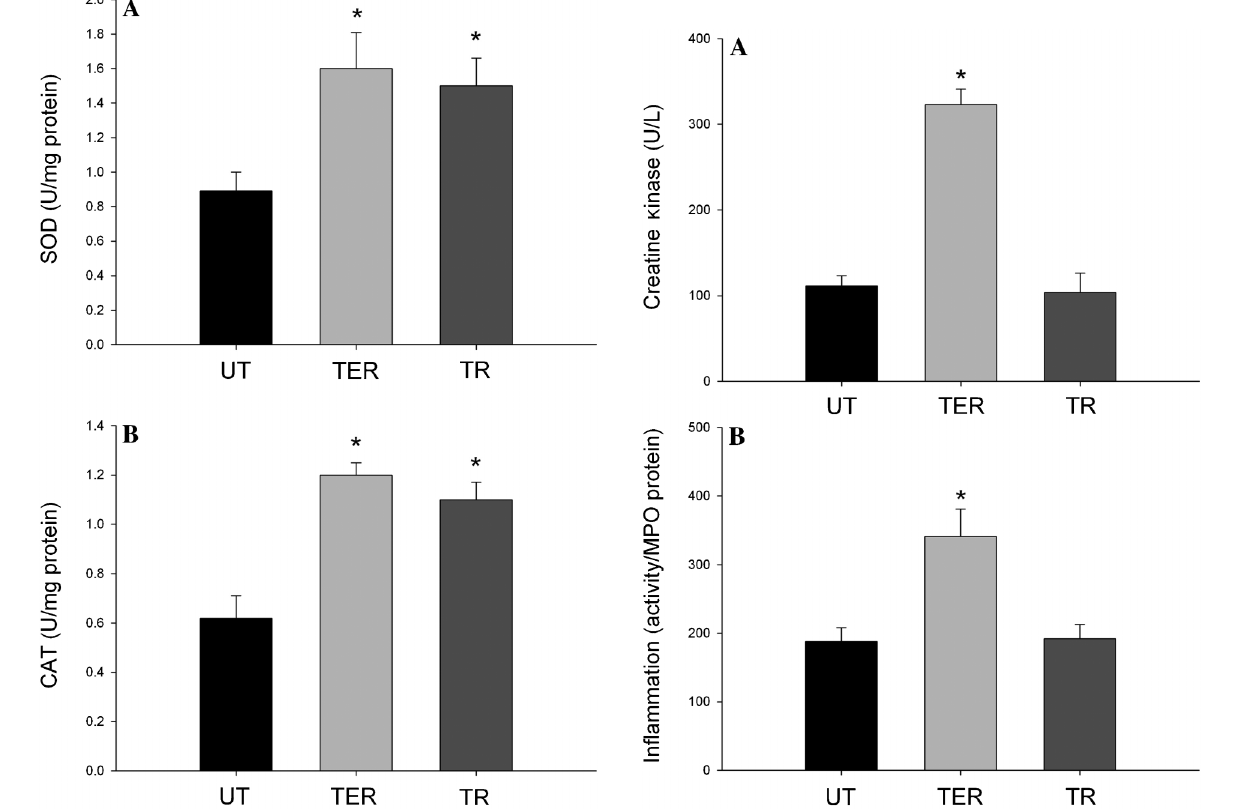
Figure 3. Antioxidant enzyme levels [ A , superoxide dismutase (SOD) and B , catalase (CAT)] were determined in skeletal muscle (red portion - quadriceps) 48 h after the last training session. The animals were divided into 3 groups (N = 6 each): UT = untrained; TER = trained eccentric running (16 ˚ ); TR = trained running (0 ˚ ). Data are reported as means ± SE. *P , 0.05 compared to the UT group (Tukey HSD test).